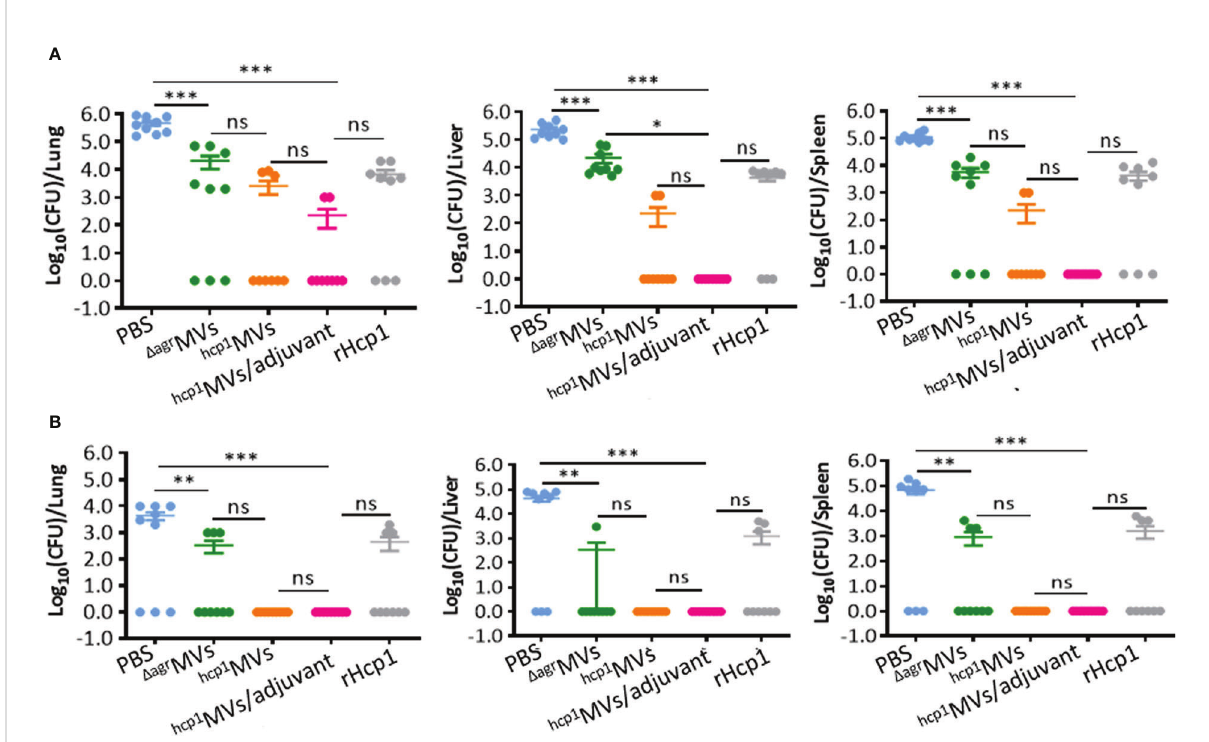
FIGURE 6 Bacterial enumeration in vaccinated mice challenged with B. pseudomallei . Viable bacteria in lungs, livers, and spleens of immunized mice ( n = 9 per group) on day 0.5 (A) and 5 (B) postinfection. Tissues were weighed and homogenized in PBS. Viable bacteria were counted using the plate dilution method and calculated as CFU. Data are presented as mean ± standard error of the mean (SEM). Signi fi cant differences were analyzed by one-way ANOVA, ns indicates no difference, * P < 0.05, ** P < 0.01, and *** P <